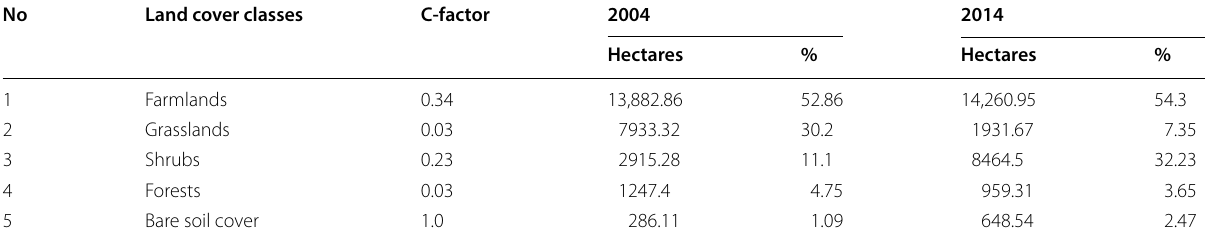
Table 4 The land cover classes and the corresponding C-factors of 2004 and 2014 at Gelda catchment, NW highlands of Ethiopia. Modified from Hurni (1985) and Prasannakumar et al.